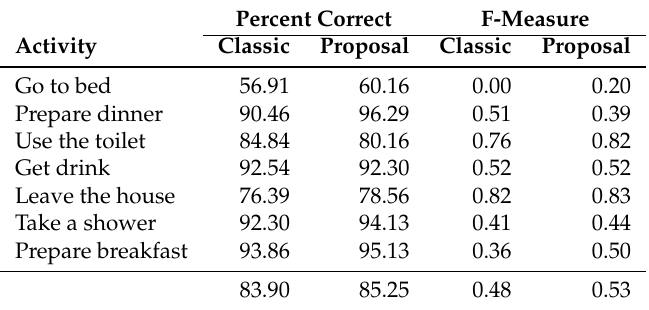
Table 13. Global classification performance in a simulation of a real